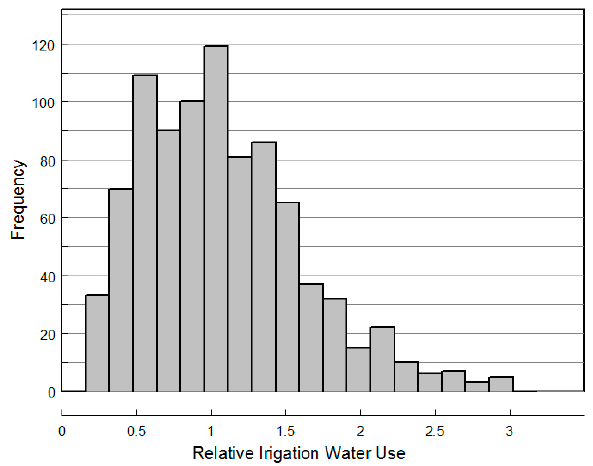
Figure 9. Frequency distribution of Relative Irrigation Water Use (RIWU) of the dairy farms in the Goulburn-Murray Irrigation District, summer 2015 – 2016.